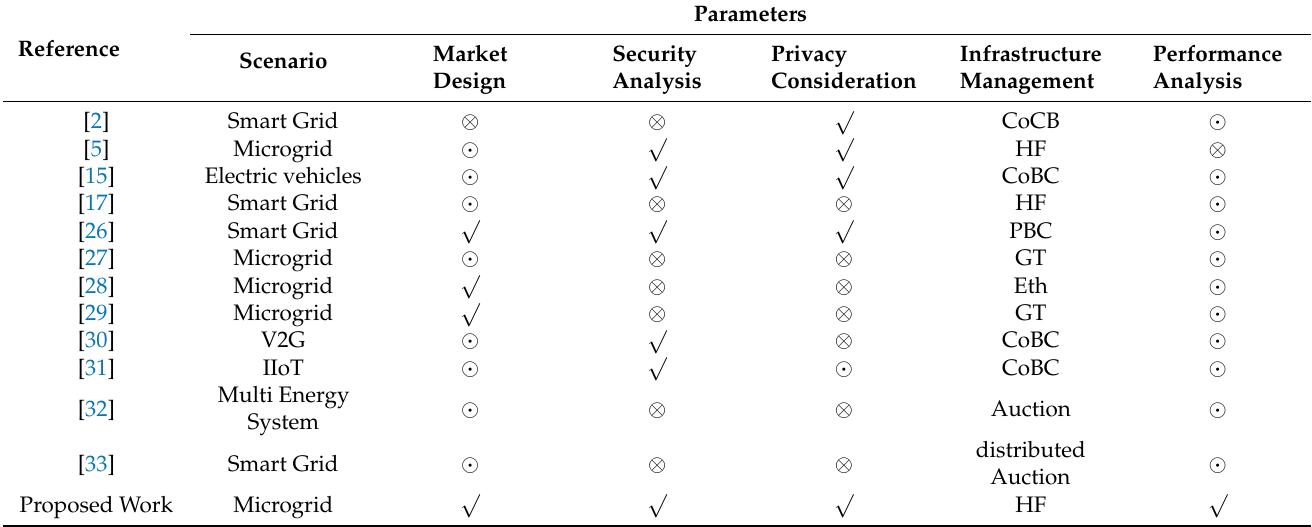
Table 1. Summary of P2P energy trading approaches in the related